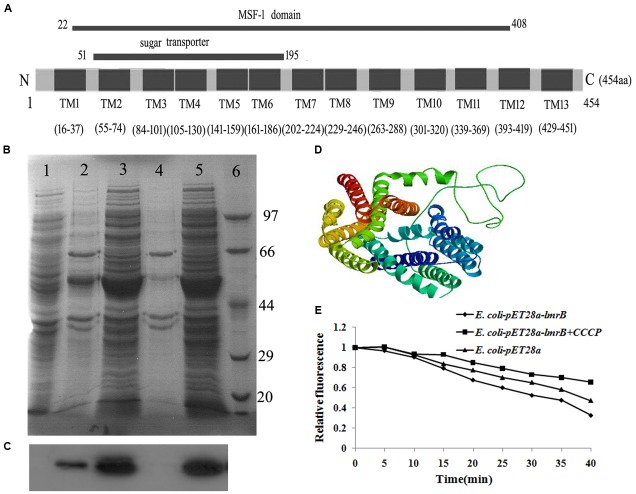
lmrB in Streptococcus mutans UA159 encoded an efflux transporter. (A) Domain architecture of LmrB. The conserved domain in the N-terminus of LmrB was found by searching CDD database on the National Center for Biotechnology Information (NCBI) website. The protein contains 13 transmembrane (TM) regions, a conserved sugar transporter domain and a MFS motif. (B) Separation of total cell lysate and isolated membrane proteins from Escherichia coli transformed with pET28a-lmrB with His-tag using SDS–PAGE profile. Lane 1: total protein of control group (E. coli cells transformed with pET28a); lane 2: membrane protein of E. coli transformed with pET28a–lmrB-His-tag; lanes 3 and 5: total protein of E. coli transformed with pET28a–lmrB-His-tag; lane 4: membrane protein of control group (E. coli cells transformed with pET28a). (C) Proteins were transferred to nitrocellulose membrane and probed with anti-His tag. The Western-blot analysis further confirmed that the recombinant protein was integrated into the membrane of E. coli. (D) The 3D model of LmrB using E. coli YajR transporter as template. (E) Fluorometric EtBr efflux assay. E. coli with pET28a-lmrB exhibited higher efflux activity characterized by the low fluorescence intensity.